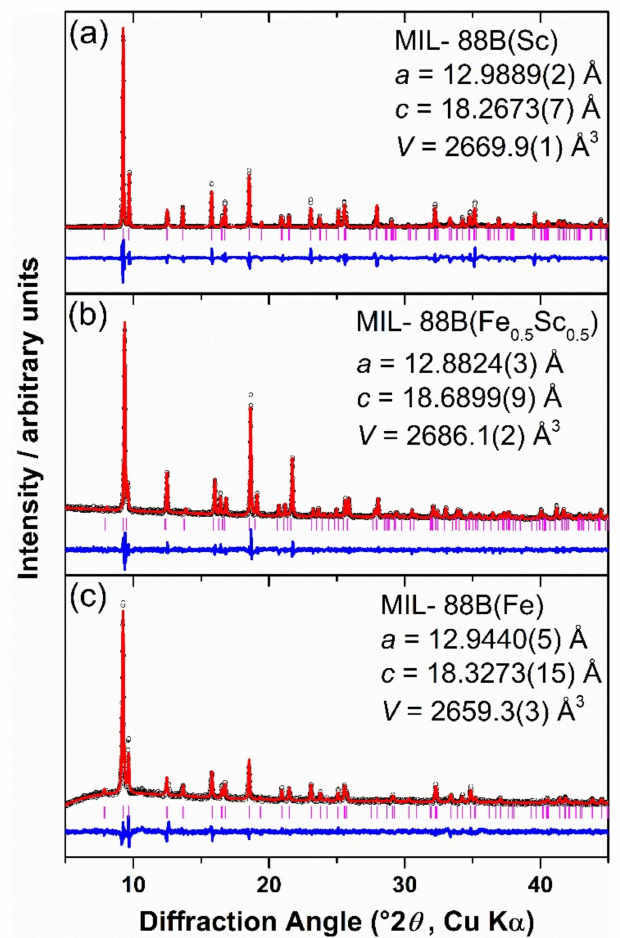
Figure 5. Profile fits to powder X-ray di ff raction patterns of ( a ) MIL-88B(Sc), ( b ) MIL-88B(Fe 0.5 Sc 0.5 ), and ( c ) MIL-88B(Fe) (Cu K α 1 radiation) fitted using space-group P 62 c . The points are the measured data, the red line is the final fit, the blue line is the di ff erence curve and the pink ticks are the positions of the allowed reflections. Refined lattice parameters and unit cell volumes are provided on each